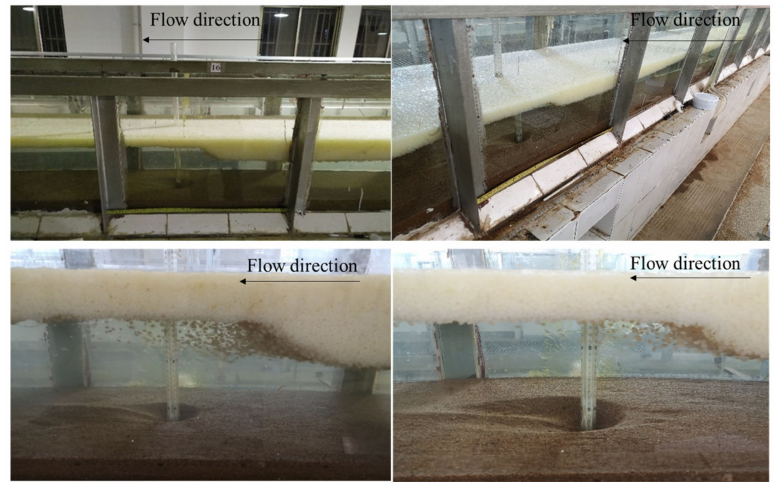
Figure 2. Ice wave migration in